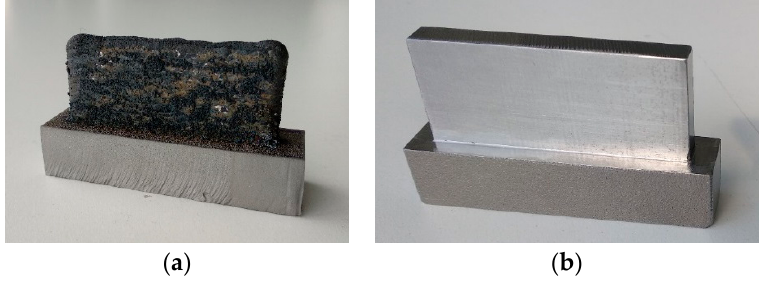
Figure 2. Walls manufactured by: ( a ) LMD-AD; ( b ) forged-SA .